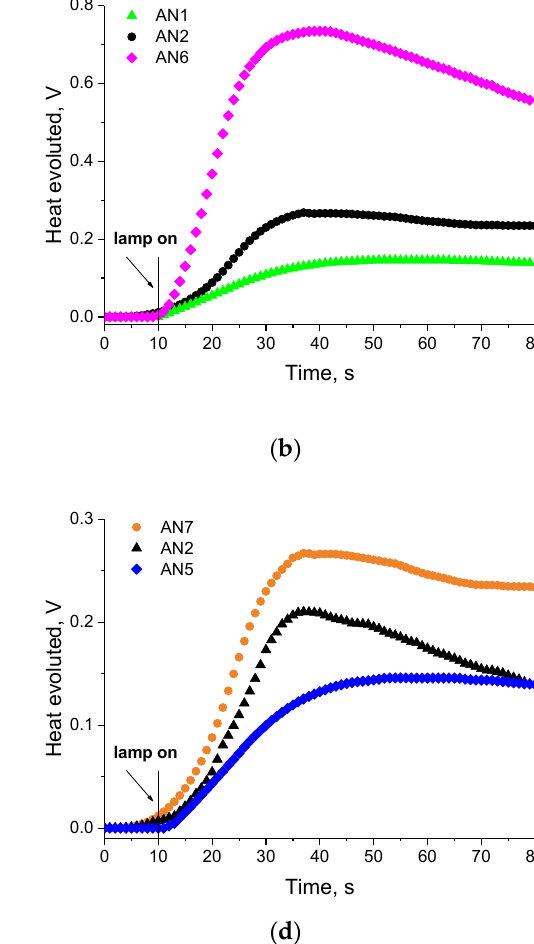
Figure 4. Family of kinetic curves recorded during the measurements of the heat flow emitted in the course of TMPTA polymerization photoinitiated by couples consisting of tested dyes and diMPhTAA co-initiator. The dyes used differ in: ( a ) the type of substituent; ( b ) the number of conjugated double bonds; ( c ) the arrangement of aromatic rings; ( d ) the number and position of the nitrogen atoms. The plots illustrate the effect of the sensitizer structure on the initiation efficiency of TMPTA polymerization. The co-initiator concentration was 0.1 M, optical density of the dyes was 1.8 at an excitation wavelength (400 nm), light intensity of dental lamp was 30 mW/cm 2